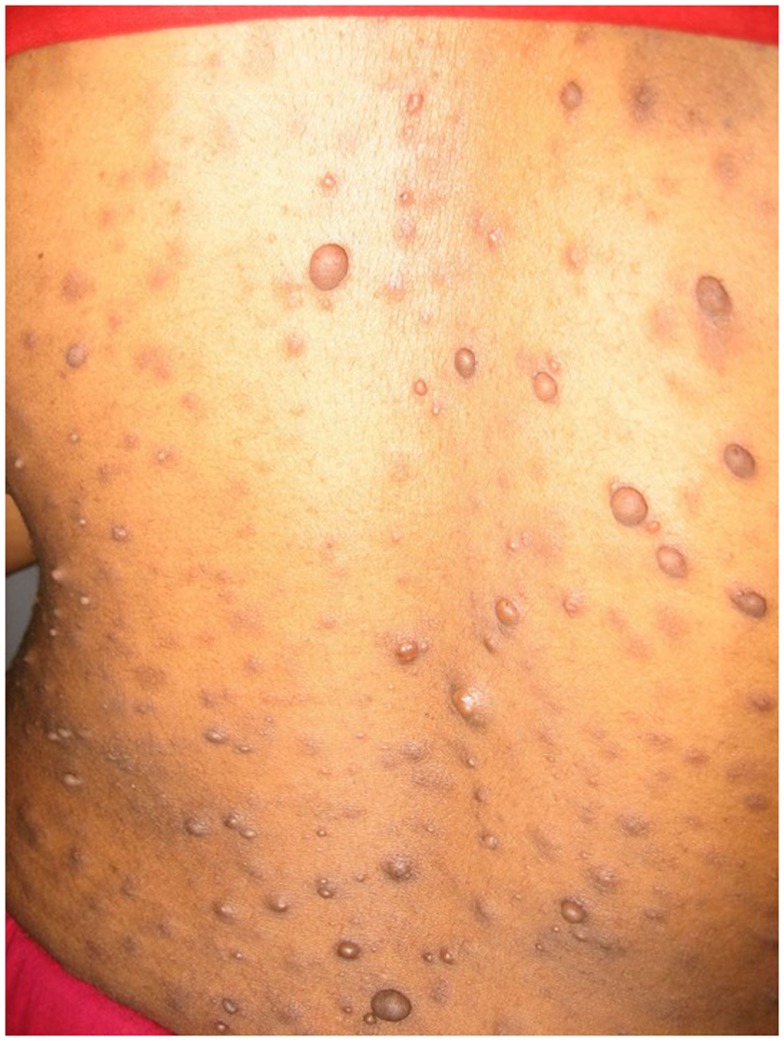
Neurofibromatosis.